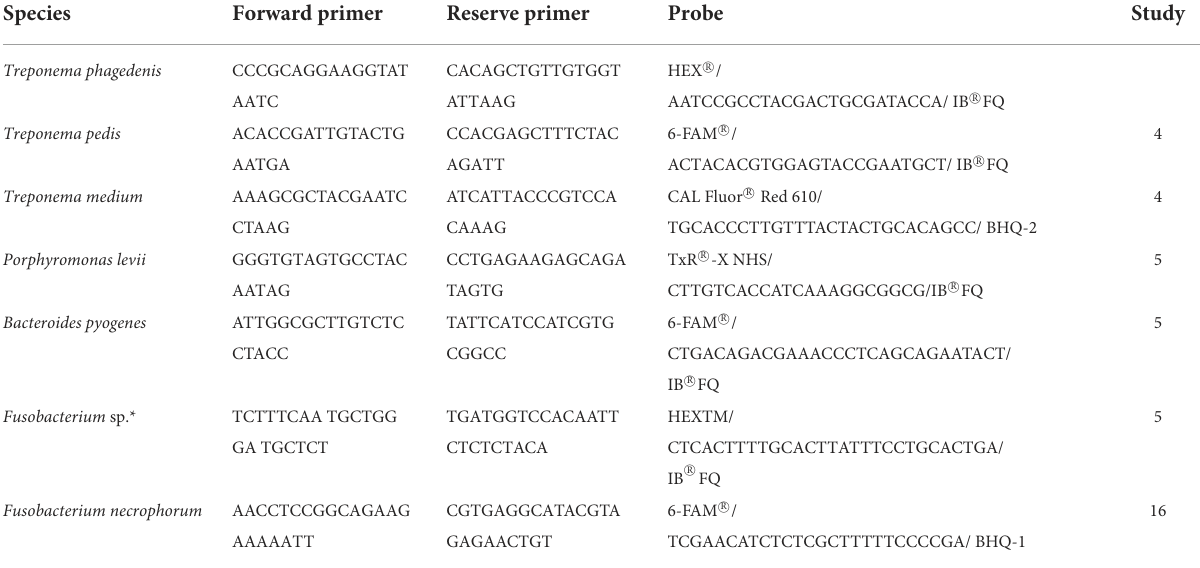
TABLE 1 Primer and probe sequences for Treponema and non- Treponema species-specific multiplex and singleplex qPCRs. Species Forward primer Reserve primer